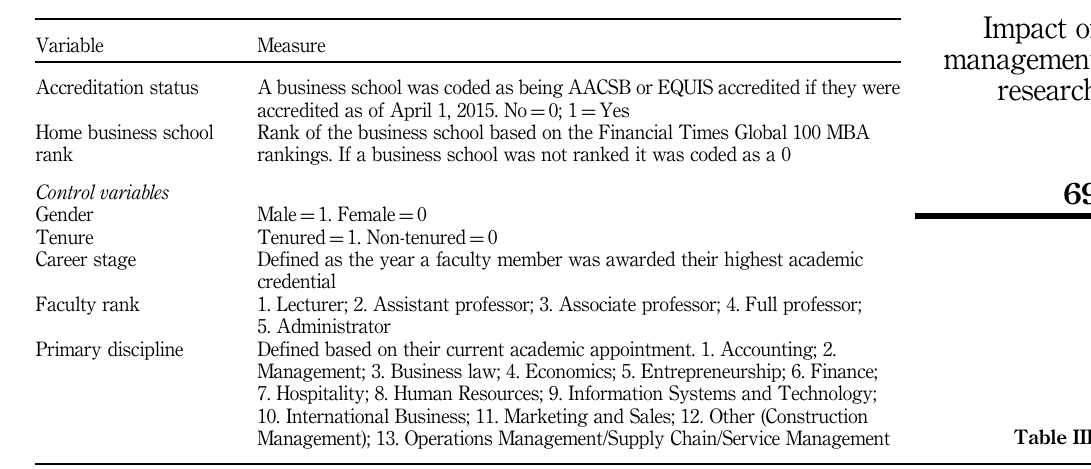
Table VI (Panels a and b) reports the results of the binomial logistic regression models. Overall, based on the Nagelkerke R 2 results, 9 of the 12 models report to be a good fit for